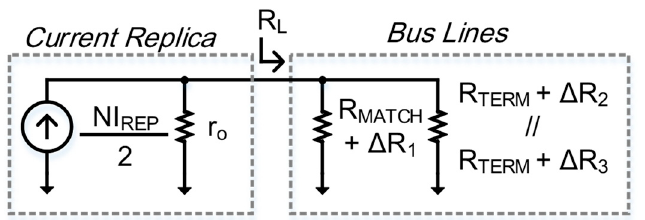
Figure 5. Small-signal model of the current replica cells and the bus line.